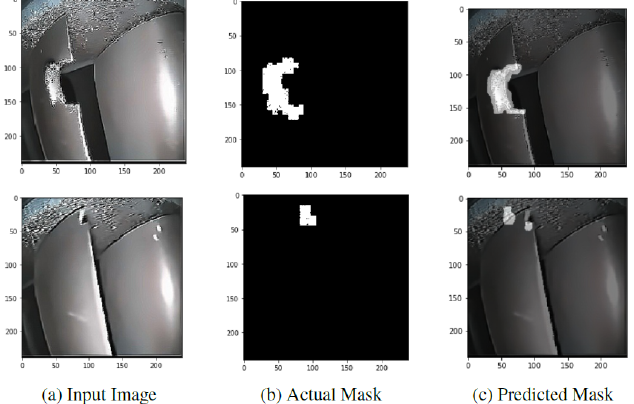
Figure A4. FL segmentation on test data after 150 epochs.